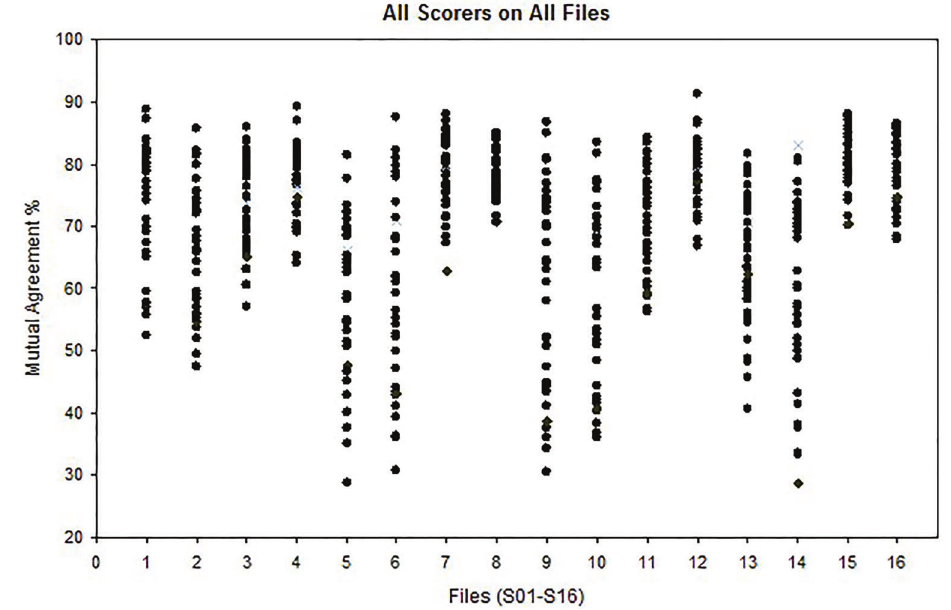
Figure 2. Scatter plot of all mutual agreement (%) values in different fi